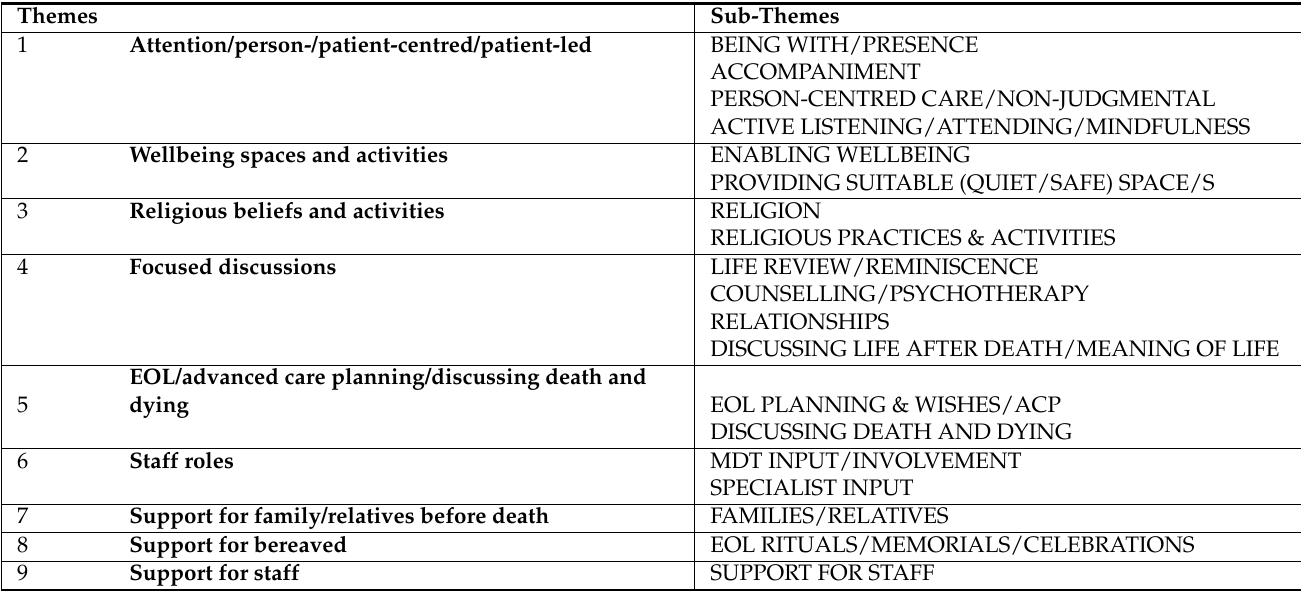
Table 7. Themes and sub-themes for responses to